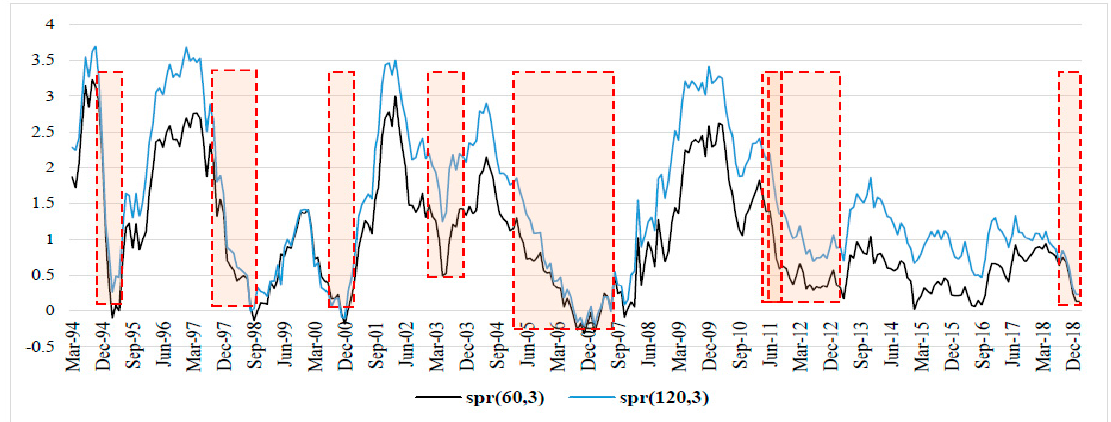
Figure 1. Yield spread-Canada.